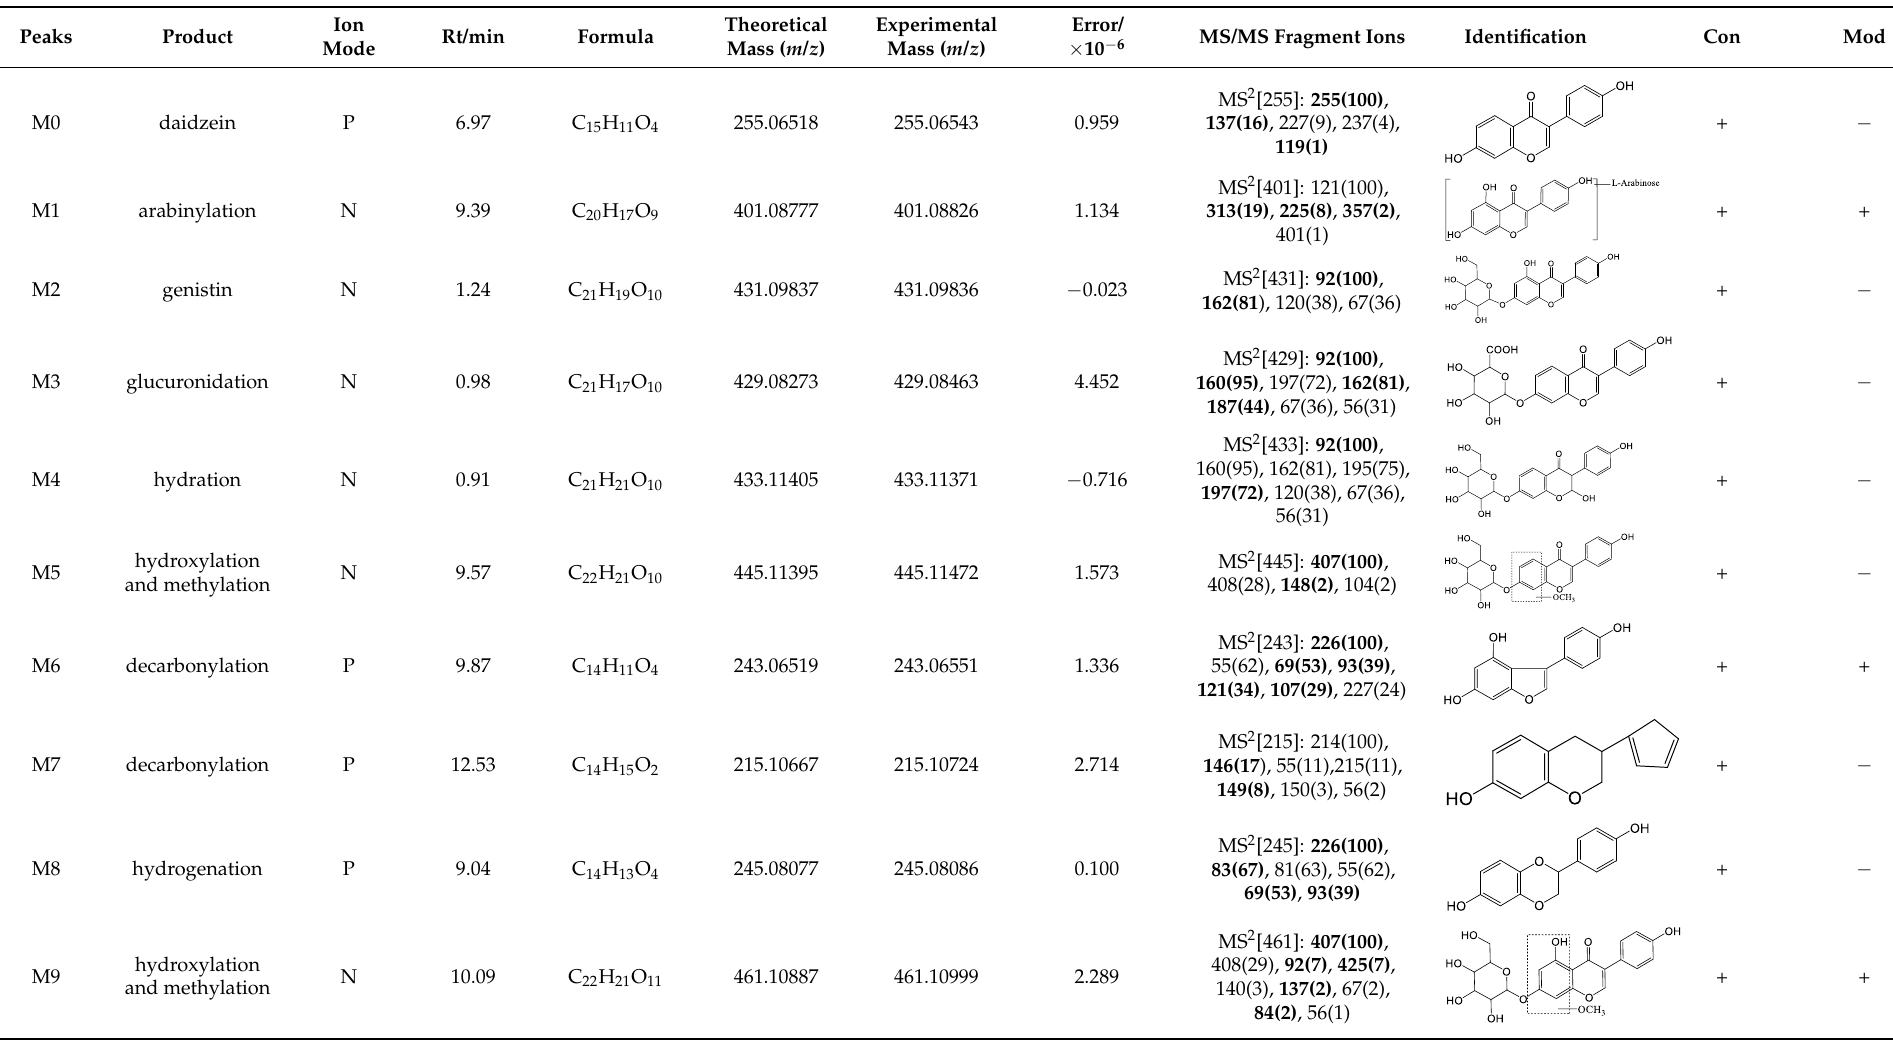
Table 1. Summary of the detection of genistin metabolites in plasma of normal rats and hyperlipidemic rats via UHPLC-Q-Exactive Orbitrap MS